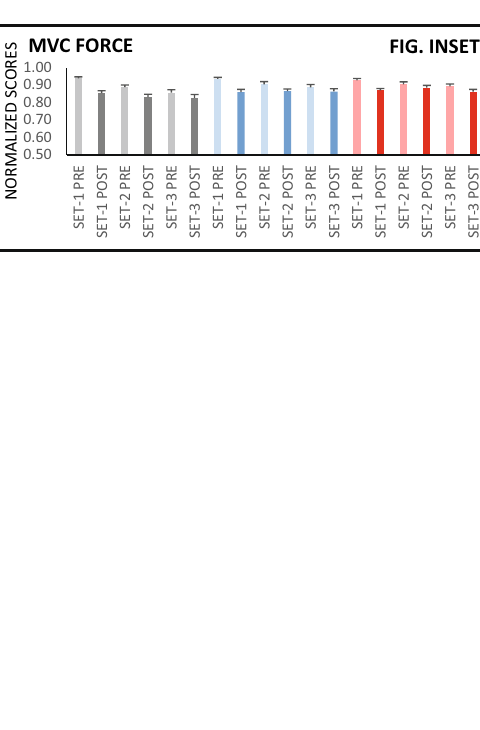
Figure 6. Effects of M1-TBS on MVC force. MVC change (PRE vs. POST FT) by pooling sets ( A ) and with set progression (inset); ( A ) shows the results on a PRE-POST basis by pooling sets; the drop in MVC force POST FT was significantly smaller in the iTBS session than in the shamTBS session, but PRE-POST changes remained significant for all stimulation modes, as denoted by asterisks. In the three sessions conducted, MVC force decreased significantly with set progression, but the reduction was larger at PRE than at POST. The inset depicts the significantly different PRE-POST change with set progression and the significant change with set (asterisk omitted for clarity). ***p ≤ 0.001. The y-axis unit score values are shown in Table